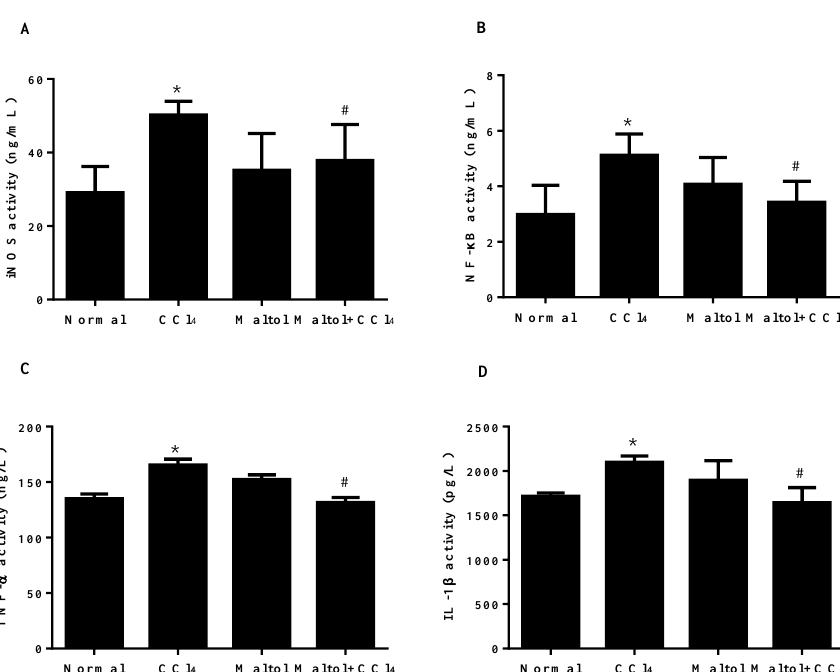
Figure 6. Pretreatment with maltol protected against CCl 4 -induced liver injury: Effects of maltol on the serum levels of irreducible nitric oxide synthase (iNOS) ( A ), nuclear factor-kappa B (NF- κ B) ( B ), tumor necrosis factor- α (TNF- α ) ( C ) and interleukin- 1β (IL- 1β ) ( D ) in CCl 4 -induced mice; values are expressed as the mean ± S.D., n = 8. * p < 0.05 vs. normal group; # p < 0.05 vs. CCl 4 group. In order to confirm the effect of maltol on inflammatory response, we further determined the expression levels of CCl 4 -induced inflammatory mediators by immunohistochemistry and western blotting analysis. As shown in Figure 7, the liver tissues of CCl 4 -treated mice showed positive staining of iNOS, NF- κB and TNF - α . Importantly, pretreatment with maltol for 15 days significantly inhibited the overexpression of TNF- α and iNOS , and suppressed the activation of NF- κB (p < 0.01 ) . Importantly, the results from western blot analysis provide the evidence that pretreatment with maltol significantly decreased the protein levels of iNOS, NF- κB, TNF - α and IL - 1β (Figure 8).